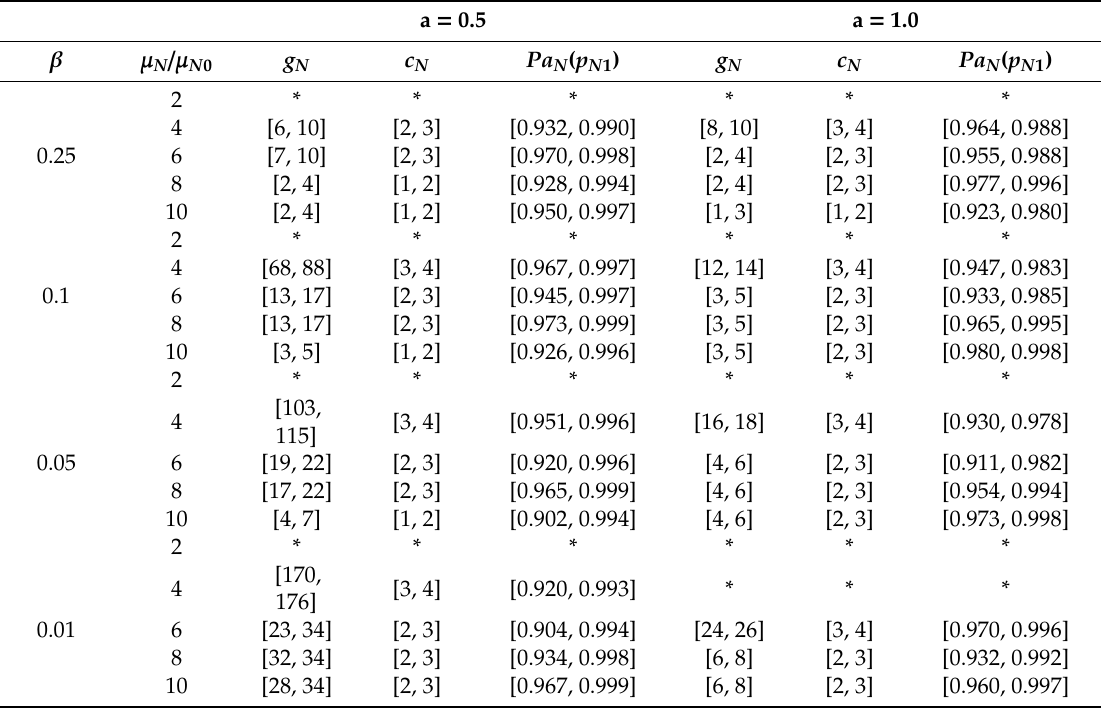
Table 3. Optimal parameters of the proposed GASP under neutrosophic statistics when r N = [4, 6] and δ = [0.9, 1.1]. N